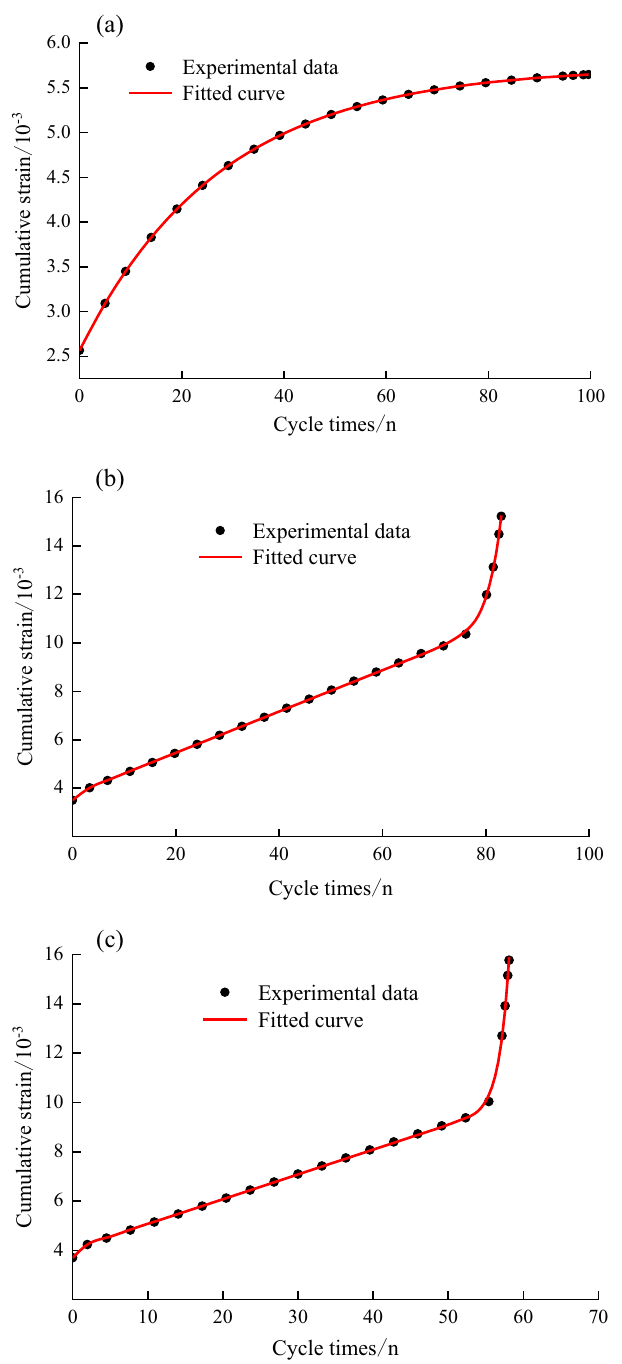
Figure 15. Fitting effect of the creep principal structure model: ( a ) σ max = 30 MPa and �σ = 5 MPa , ( b ) σ max = 36 MPa and �σ = 11 MPa , ( c ) σ max = 40 MPa and �σ = 15 MPa